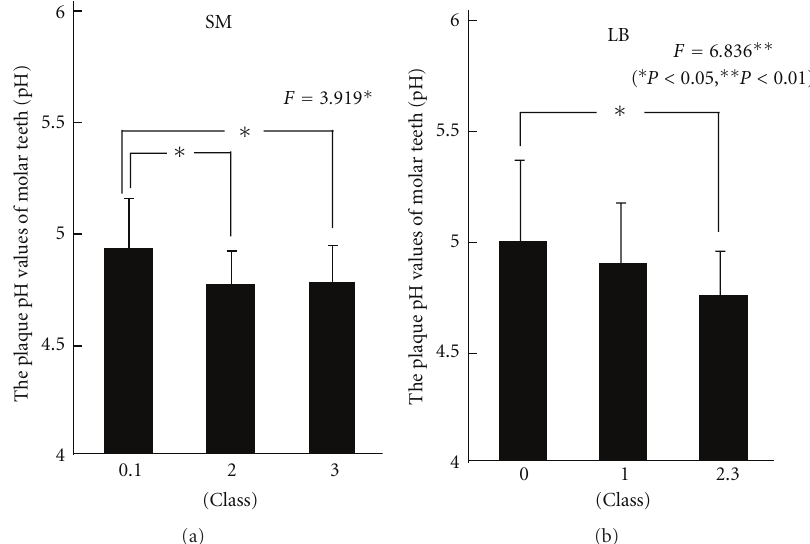
Figure 3: Relationship between the plaque pH values of molar teeth and oral environmental factor in the crown